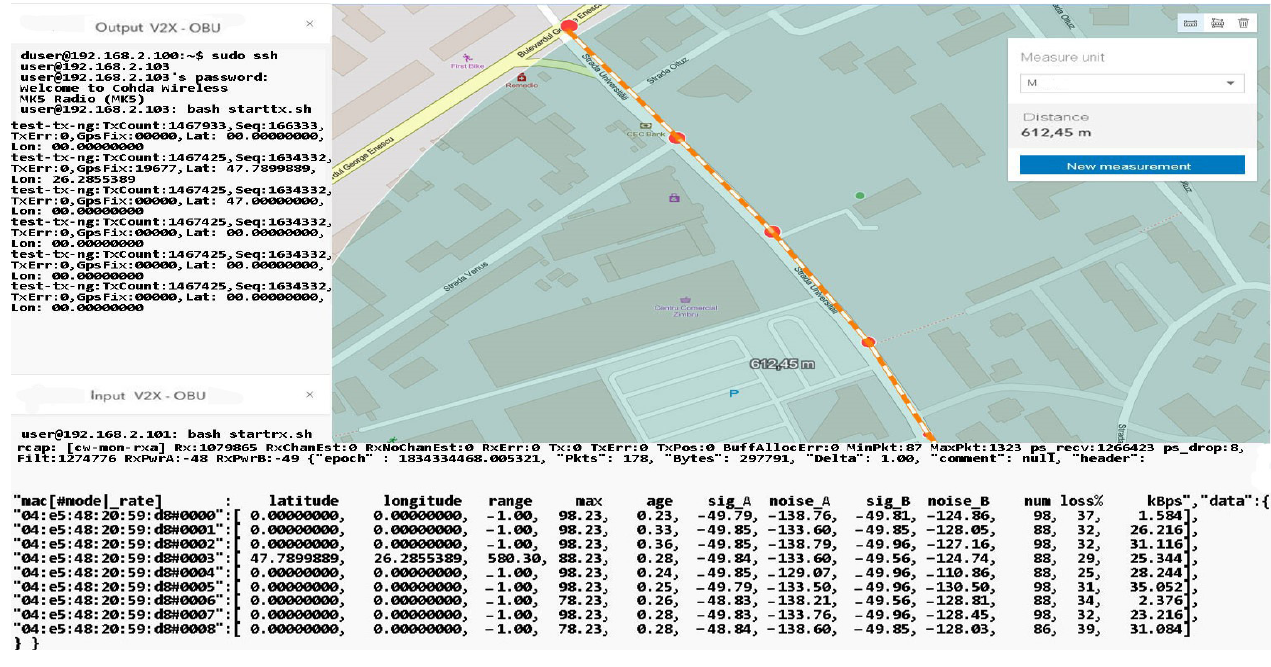
Figure 34. Simulated scenario at a distance of 612 m from the transmitter in an environment. Table 7. Simulation scenarios over a distance of over 650 m from reception, data interpretation, loss, data transfer, signal, and